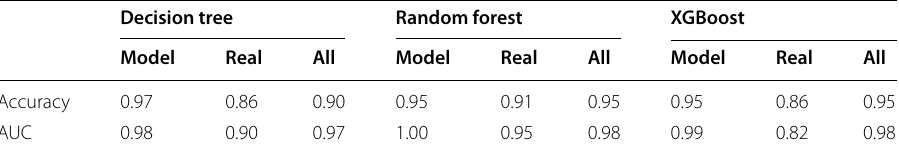
Table 6 Accuracy and AUC scores of the different algorithms on the fractal/non‑fractal classification task, on the three datasets